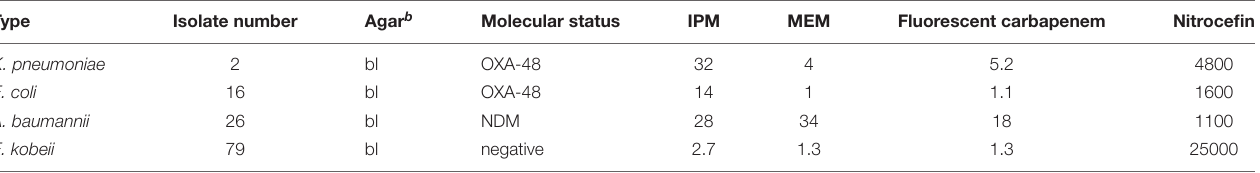
TABLE 4 | Relative beta-lactamase activity of selected bacterial extracts a